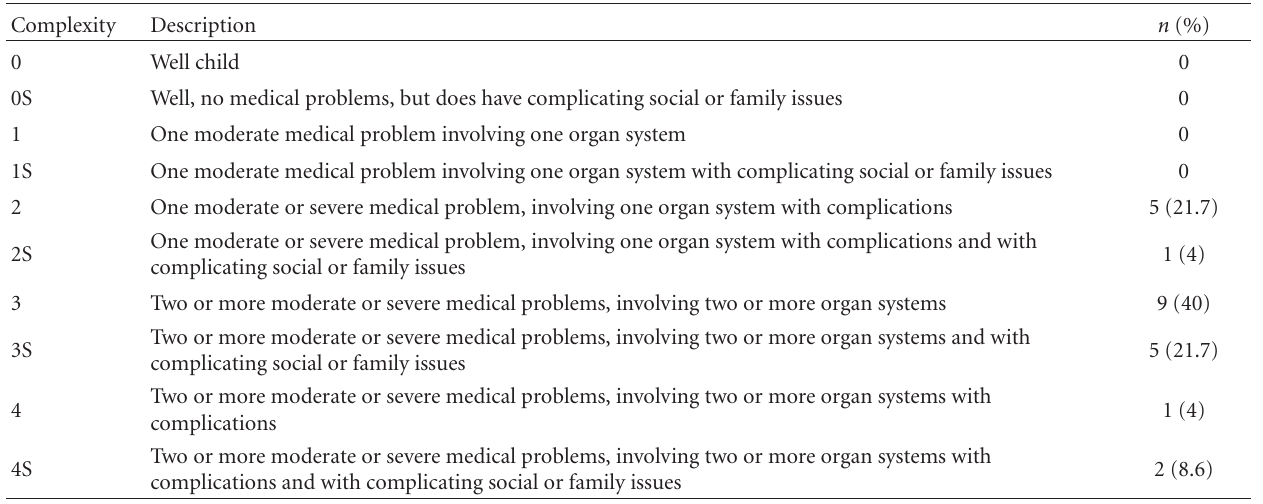
Table 3: Complexity Index Scores.